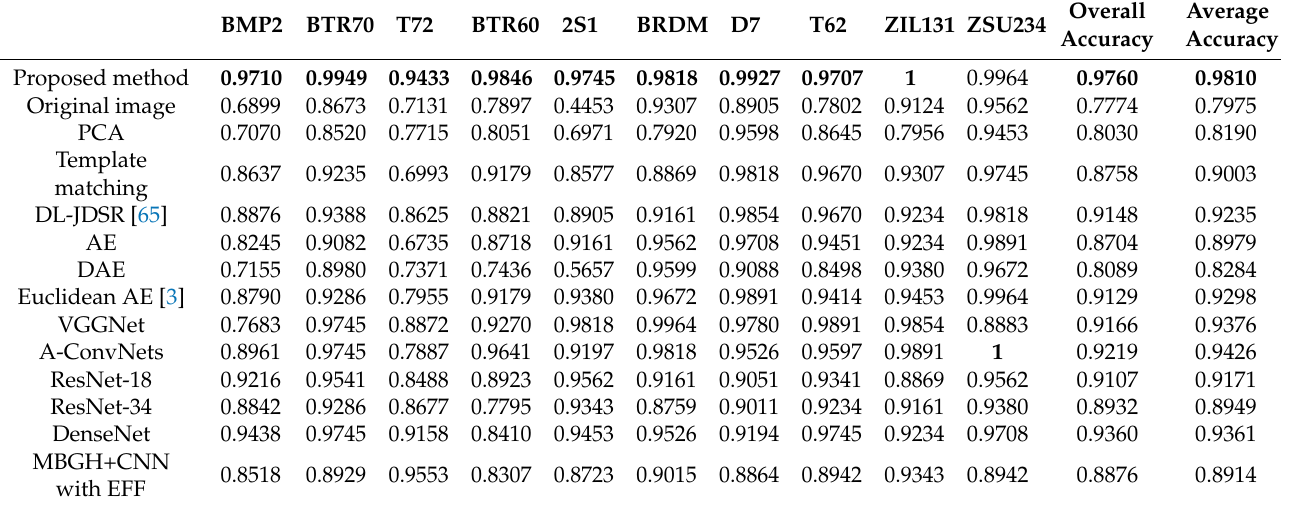
Table 7. Detailed Accuracies of Different Types in the Ten-Target Data via Some SAR Recognition